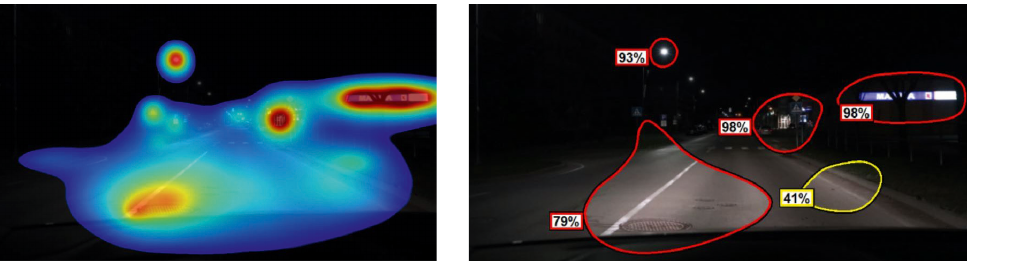
Figure 4a. 3M VAS heatmap analysis Figure 4b. 3M VAS region analysis